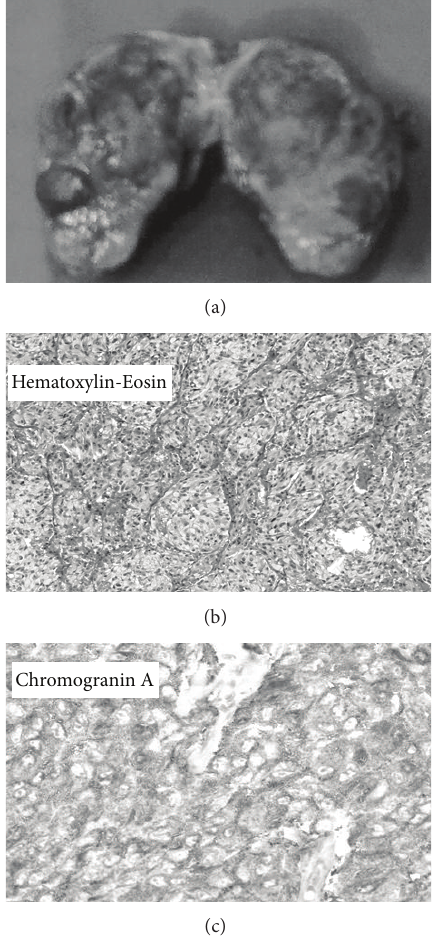
Figure 3: (a) Resected specimen (55 × 45 mm pseudocapsulated mass). Histology showed (b) paraganglioma with a nesting pattern (hematoxylin-eosin, × 200) and (c) strong cytoplasmic immunore- activity for chromogranin A ( ×